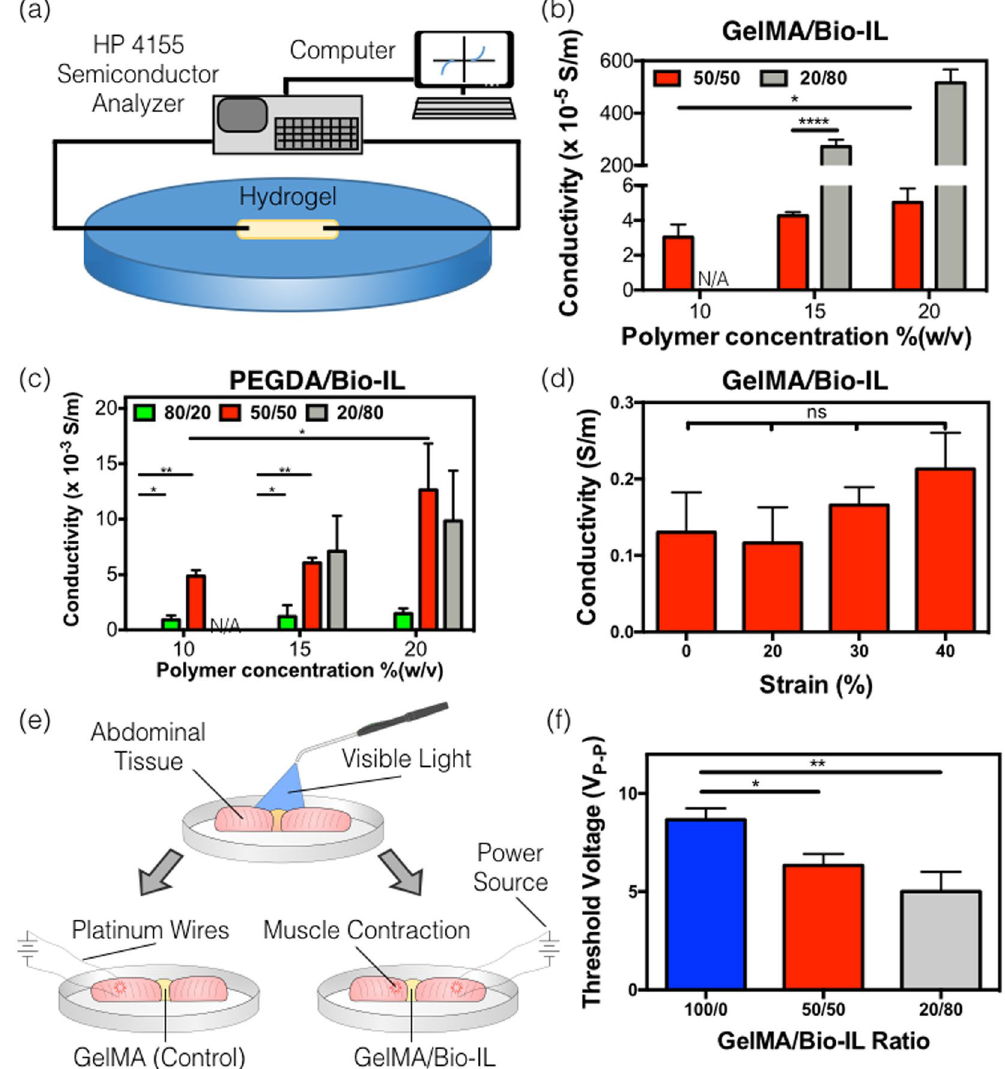
Figure 2. Electrical conductivity of the engineered polymer/Bio-IL hydrogels crosslinked by visible light. ( a ) Experimental set-up of the two-probe electrical station used to measure the electrical conductivity of the engineered hydrogels. Conductivity measurements of Bio-IL conjugated ( b ) GelMA and ( c ) PEGDA hydrogels at different polymer concentrations and polymer/Bio-IL ratios (1% VC, 1.5% TEOA, 0.1 mM Eosin Y, and 120 s exposure to visible light were used to form GelMA and PEGDA hydrogels). ( d ) Electrical conductivity of 15% GelMA/Bio-IL composite hydrogels at 50/50 ratio, which was stretched up to 0%, 20%, 30%, and 40% strain level demonstrating no significant changes in conductivity after stretching. ( e ) Schematic of ex vivo experiments performed using rat abdominal muscle tissues, connected using 15% final polymer concentration and 50/50 GelMA/Bio-IL ratio, and pure GelMA hydrogels ( f ) Threshold voltages at which contraction was achieved using 15% final polymer concentration GelMA/Bio-IL at 50/50 and 20/80 ratios, as well as pure 15% GelMA hydrogels. Error bars indicate standard error of the means, asterisks mark significance levels of p < 0.05 ( * ), p < 0.01 ( ** ), and p < 0.001 ( ***